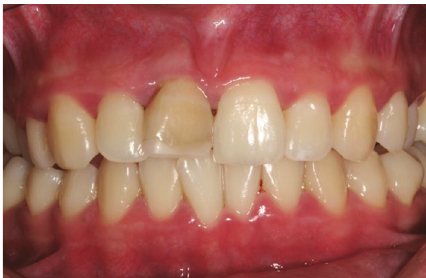
Figure 5: Crown darkening of maxillary right central incisor.